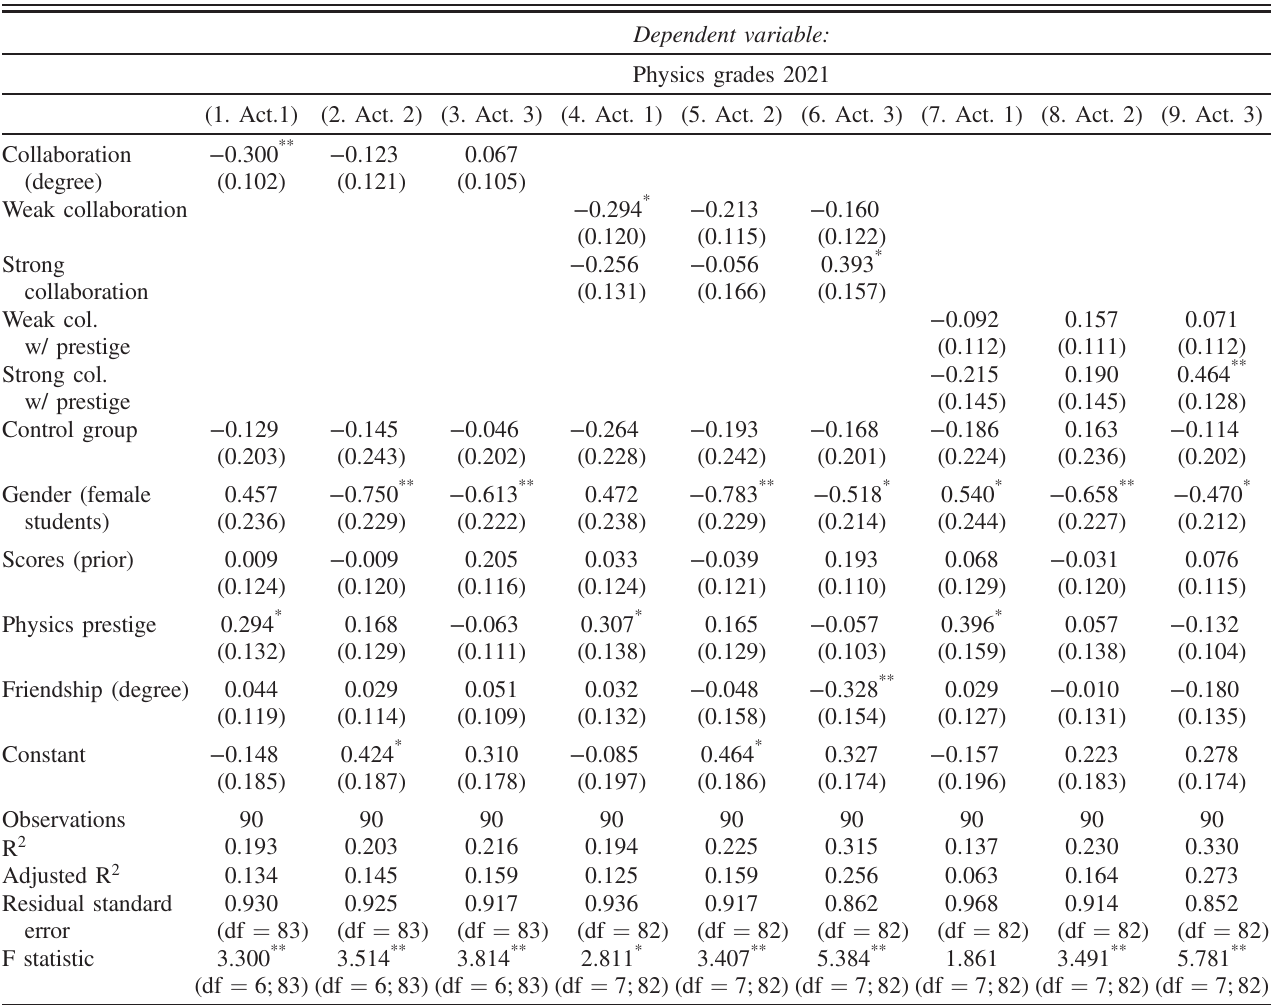
TABLE VI. OLS multiple regression models of physics grades regressed on collaboration predictors and controlling for confounding variables.